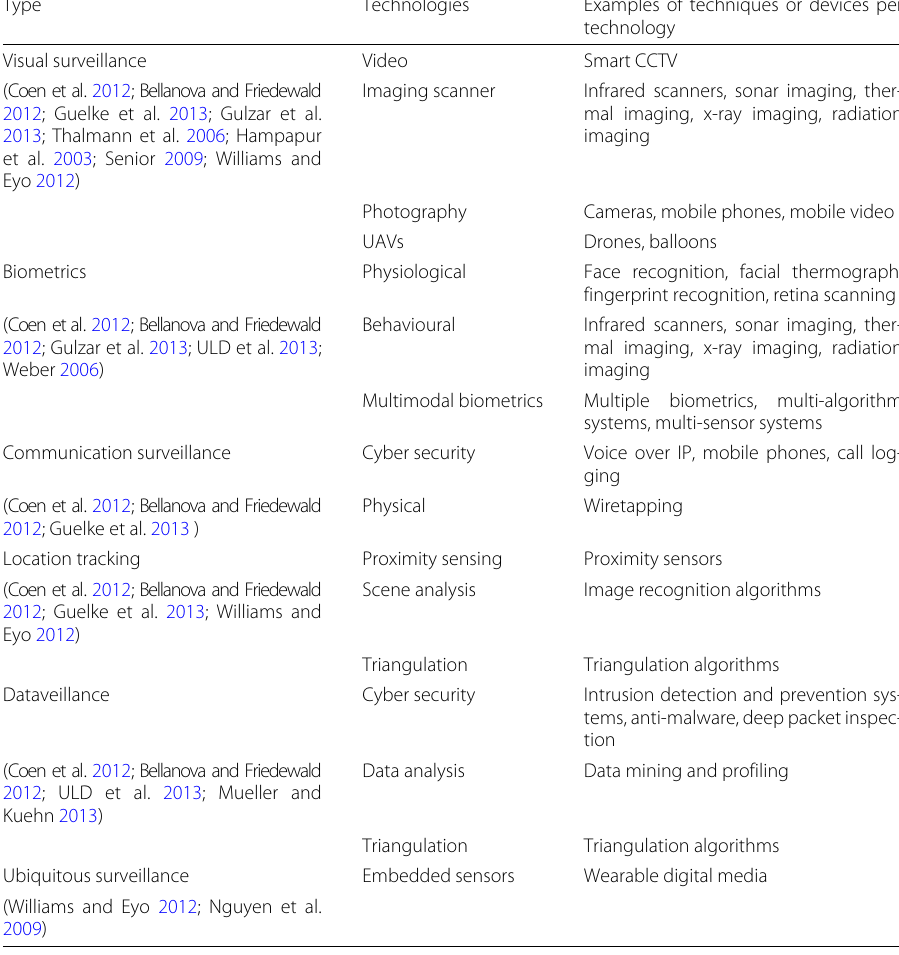
Table 1 List of surveillance and security technologies